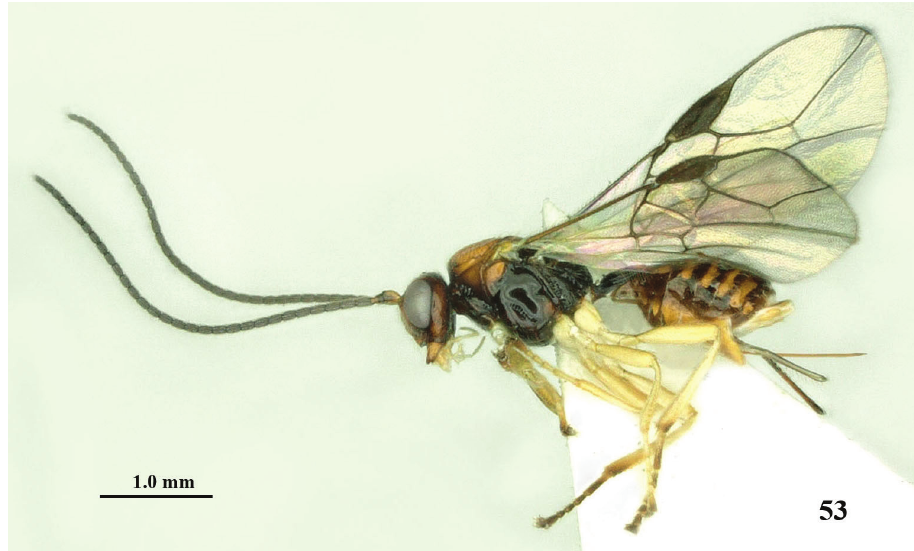
Figure 53. Rhogadopsis pratellae (Weng & Chen), female, China, Liupan Mt., habitus lateral.